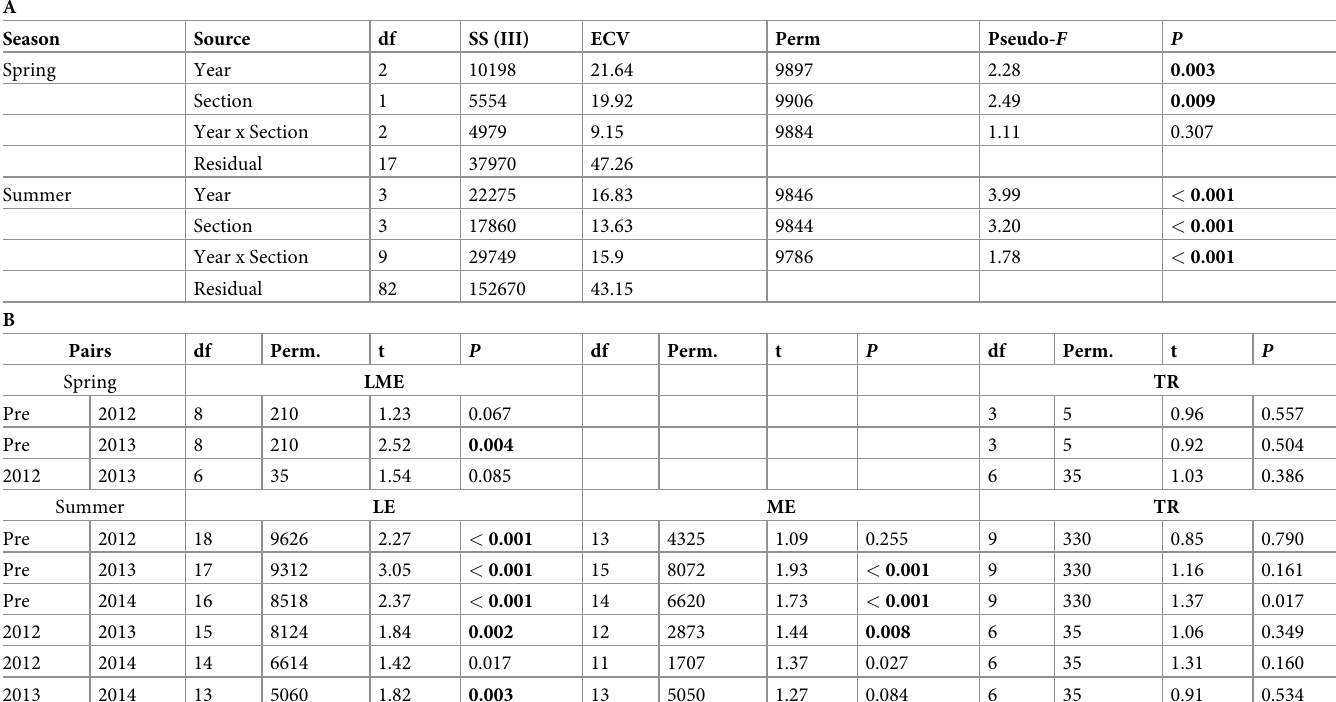
Table 5. River PERMANOVA results for spring and summer invertebrate drift for: (a) Main tests of year, section, and year x section effects, and (b) Pairwise com- parisons for year x section interaction. A